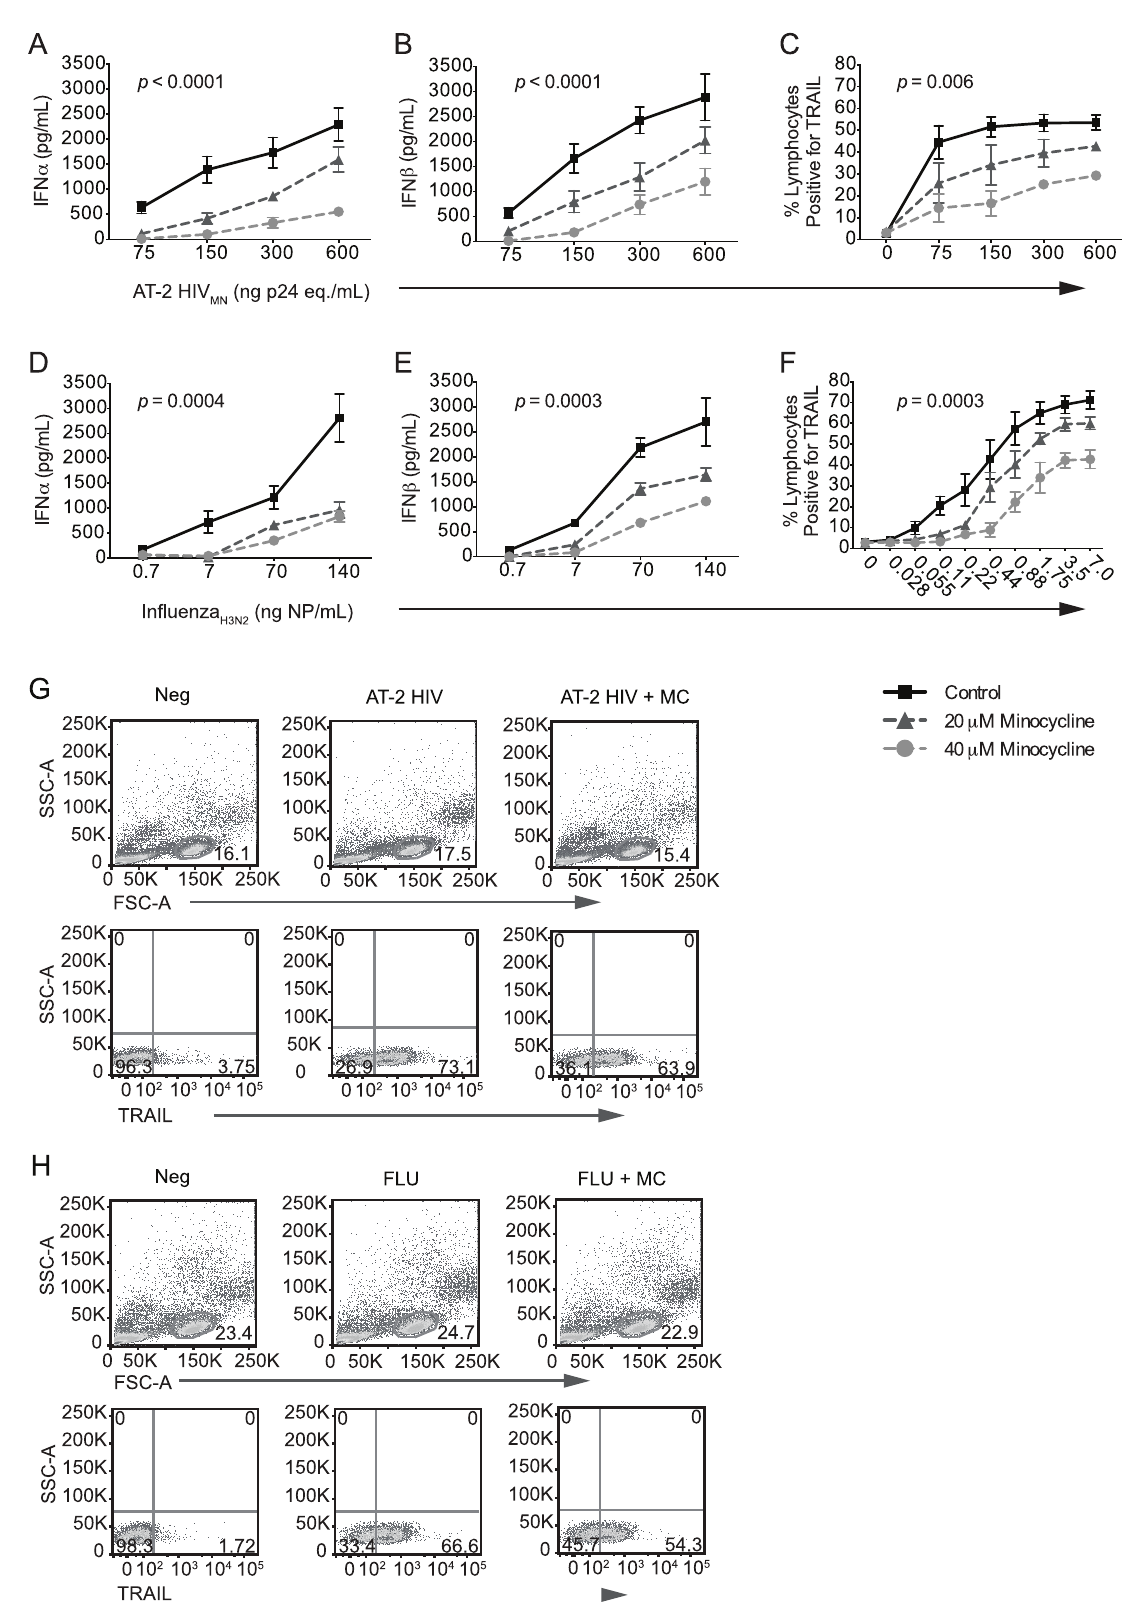
Figure 2. Minocycline attenuates type I IFN production and TRAIL expression in lymphocytes. PBMCs were isolated from the blood of healthy human donors, pretreated for two hours in vitro with 0, 20, or 40 m M minocycline, and exposed to increasing amounts of either AT-2 inactivated HIV ( n =4 different donors) or infectious influenza virus ( n =3 different donors). After overnight culture, supernatants were analyzed for